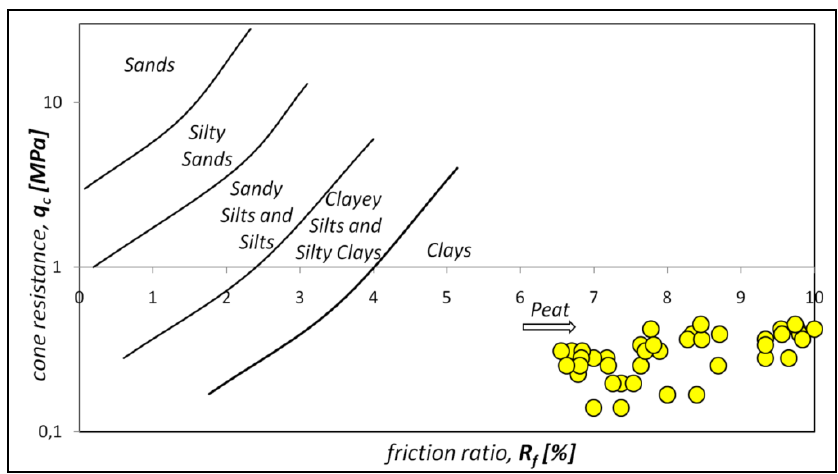
Figure 7. Diagrams present the identification of organic soils based on CPTM tests, according to the propositions of Robertson and Capanella’s nomogram.